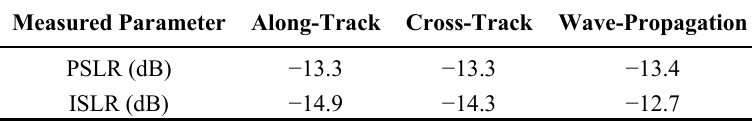
Table 4. The measured PSLR and ISLR with wave front curvature error